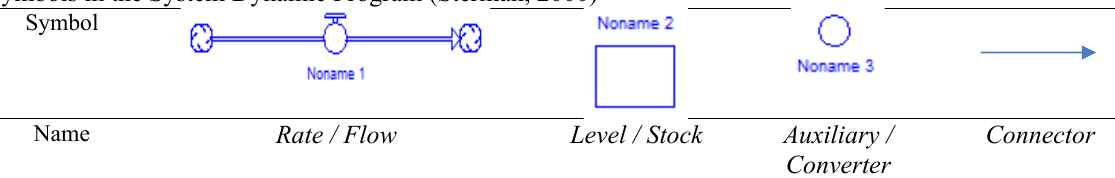
Symbols in the System Dynamic Program (Sterman,